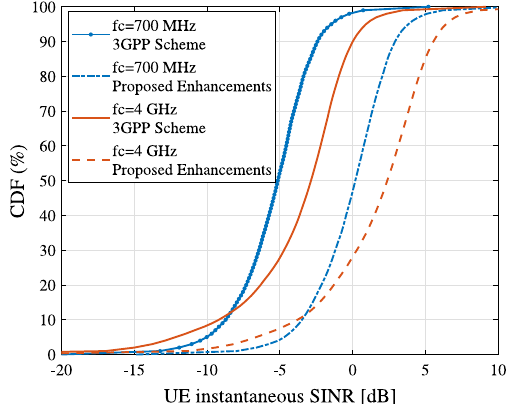
Fig. 12 Uplink SINR CDF with 20% duty cycle